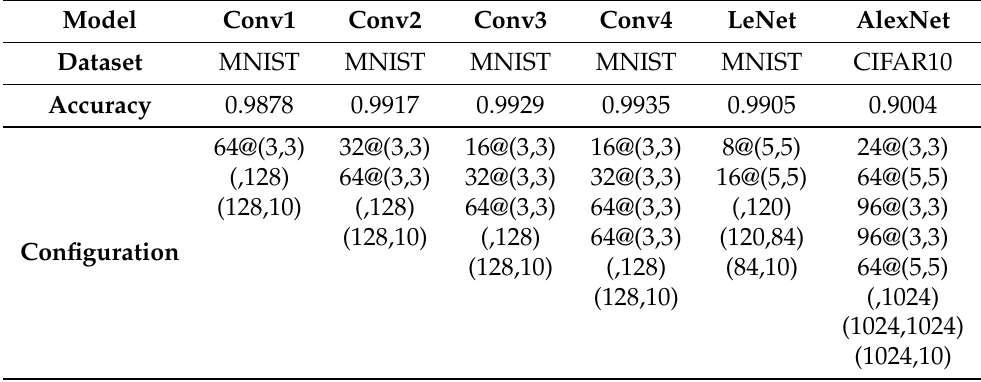
Table 1. Detailed neural network variants, consisting of the configuration, accuracy and used